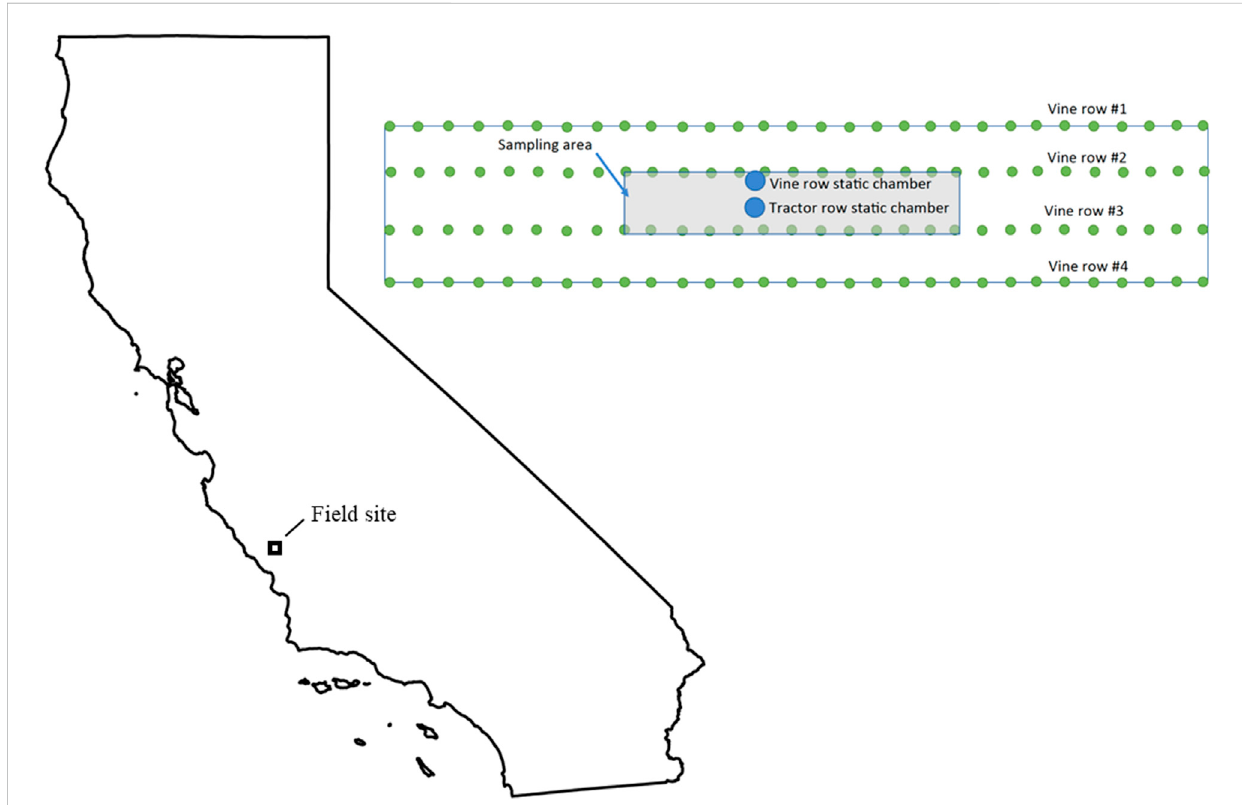
FIGURE 1 Ageographicalmapofthe fi eldsitelocatedinPasoRobles,CA,andaschematicoftheexperimentaldesignofthestudyillustratingthesamplingarea and the functional locations.